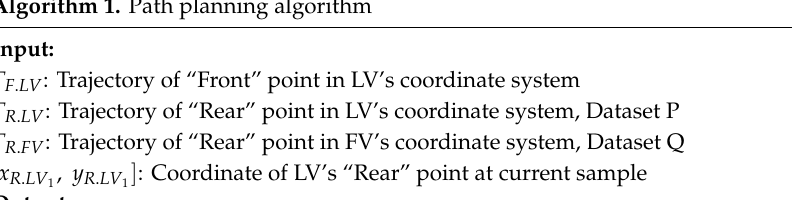
Algorithm 1. Path planning algorithm